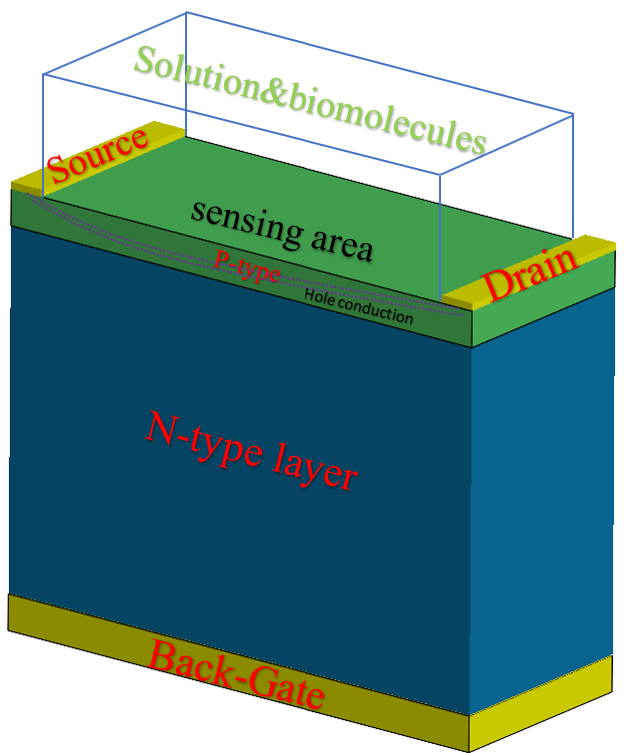
Figure 1. Schematic of OG-FET sensor showing the main material composition of the sensor. The sensing layer of OG-JFET is the p-type silicon between two electrodes of source and drain. The open-gate area is covered with the native oxide layer that usually appears when silicon is exposed to air.